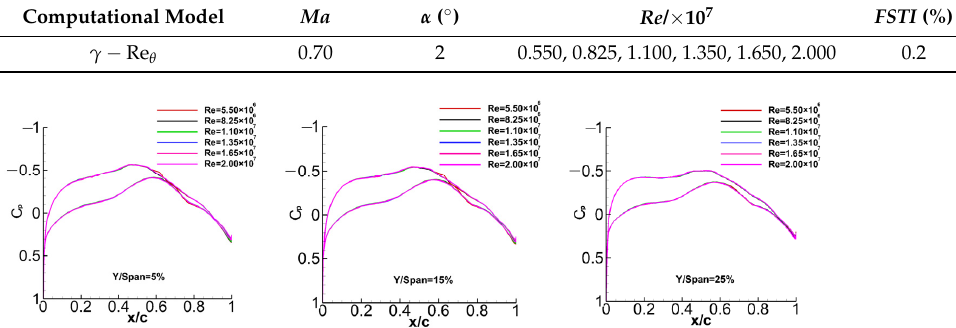
Figure 12. Comparison of C p curves of the central experiment wing with different Re at various locations along the span.